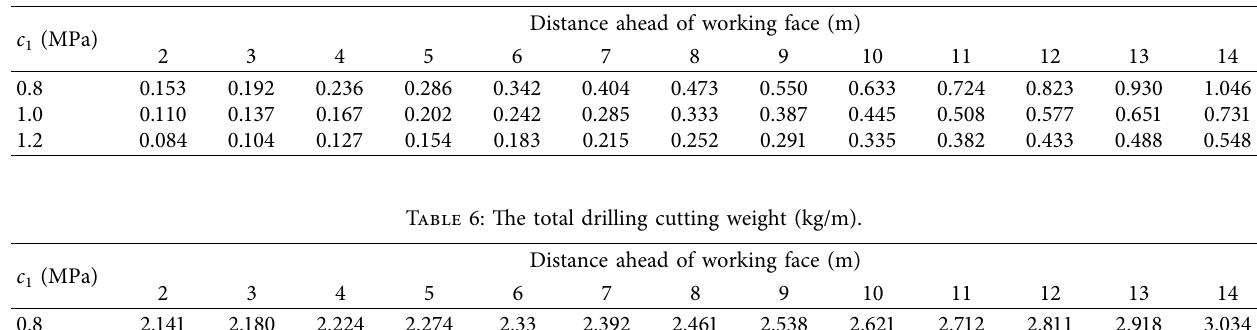
Table 5: The drilling cutting weight caused by plastic displacement at various points ahead of the working face (kg/m).